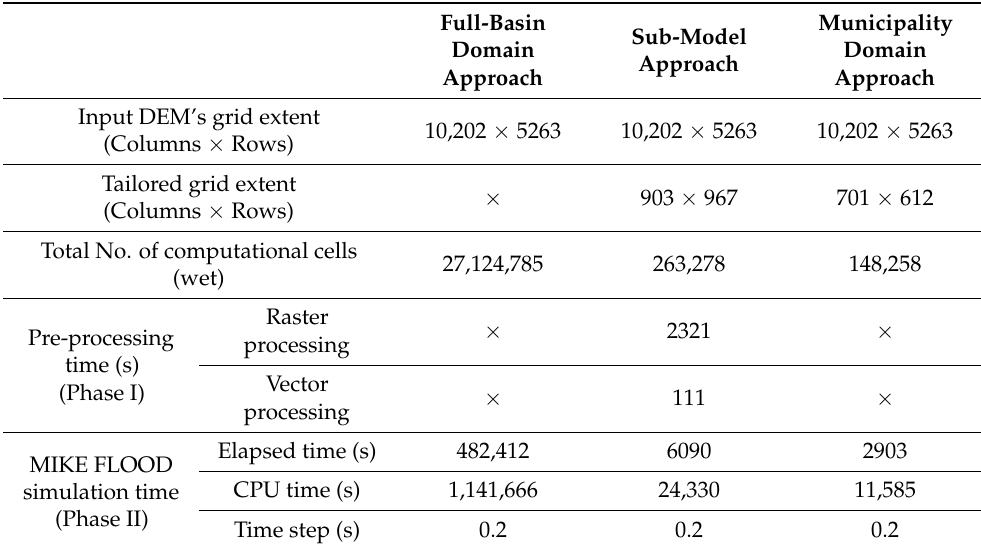
Table 3. Comparison of computational efficiency when using different domain